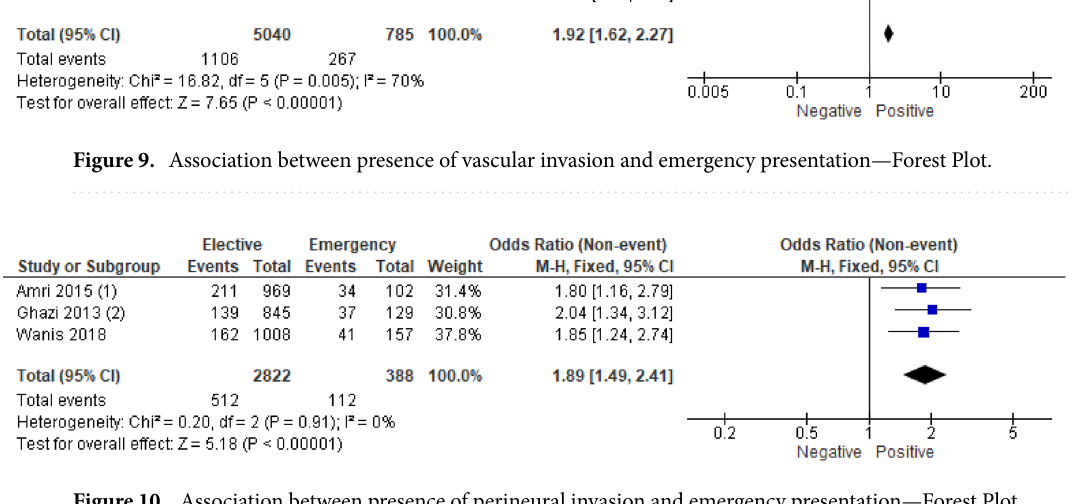
Figure 10. Association between presence of perineural invasion and emergency presentation—Forest